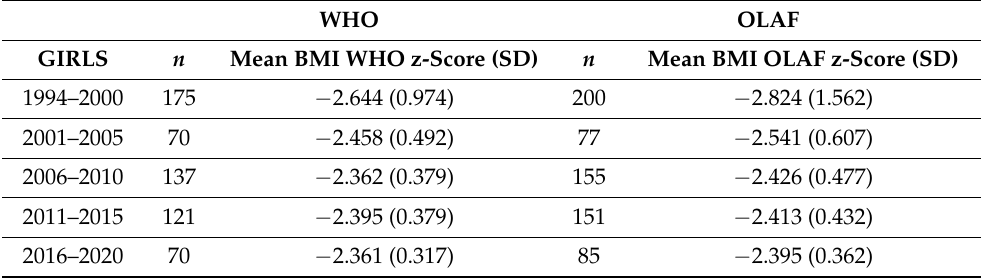
Table 2. Mean z-score in underweight girls by year of study and methods. WHO